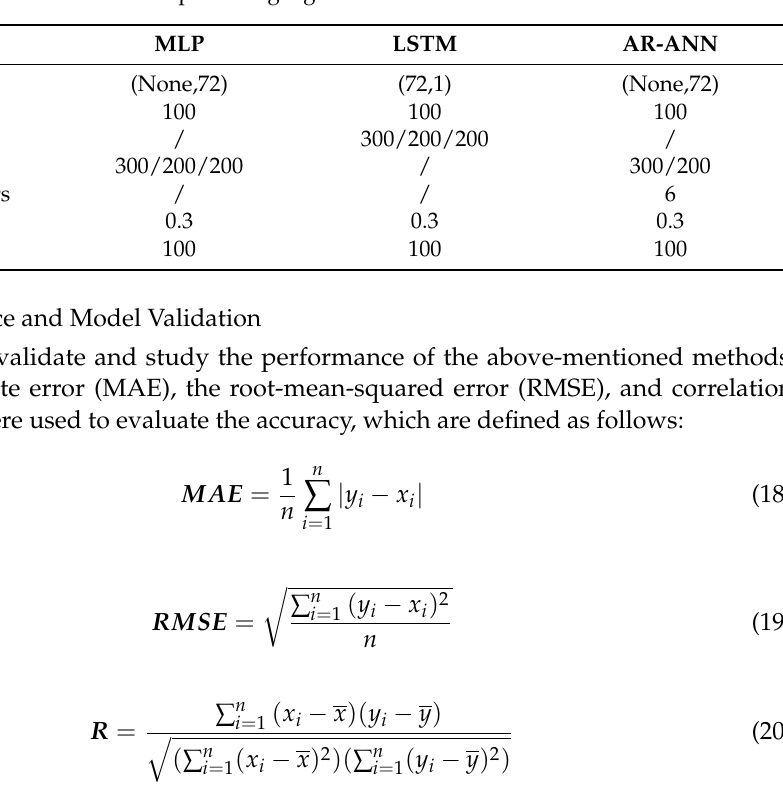
Table 1. Detailed information for deep learning